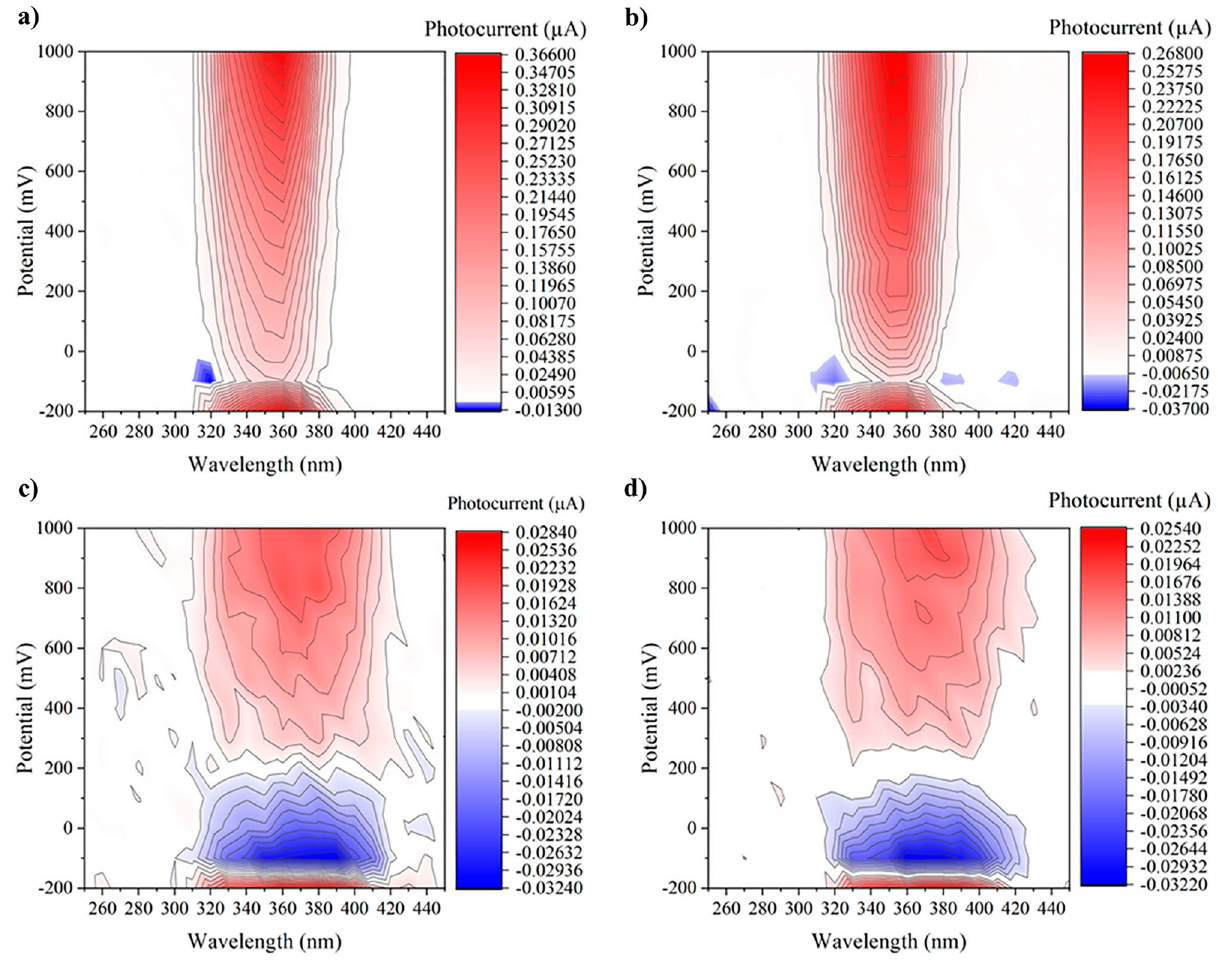
Figure 13. Photocurrent generation as a function of potential and wavelength for ( a ) TiO 2 -A; ( b ) TiO 2 -A-0.5% Ag, ( c ) MM-g-CN, and ( d ) MM-g-CN-0.5%